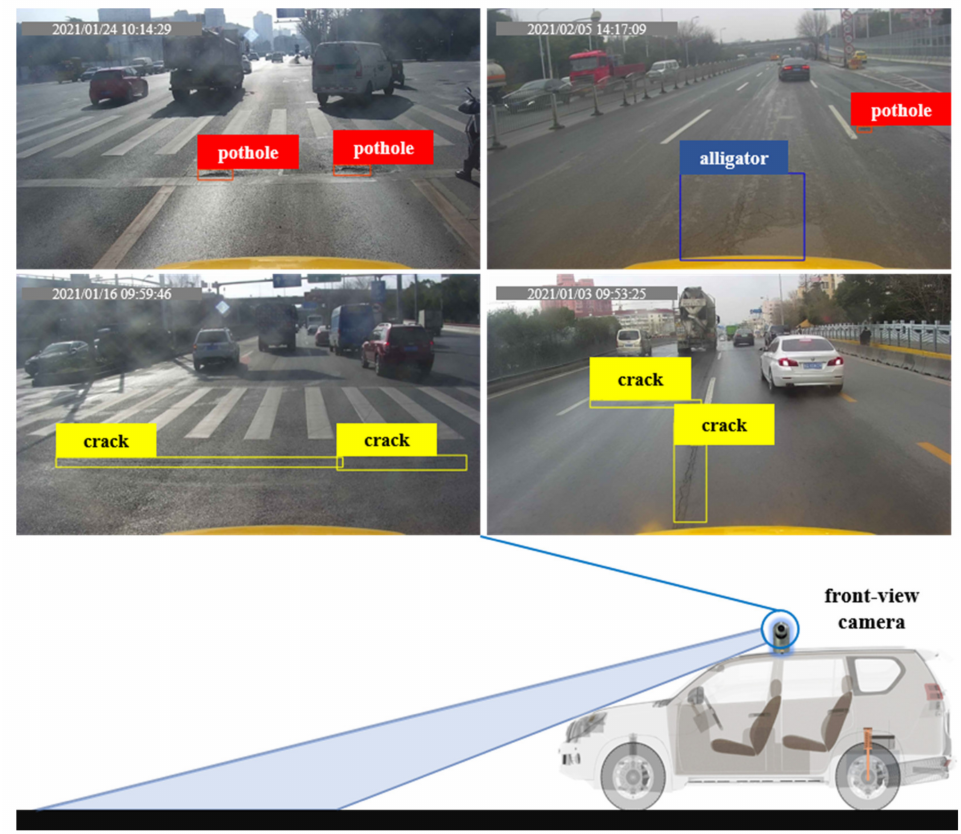
Figure 3. Detection of pavement